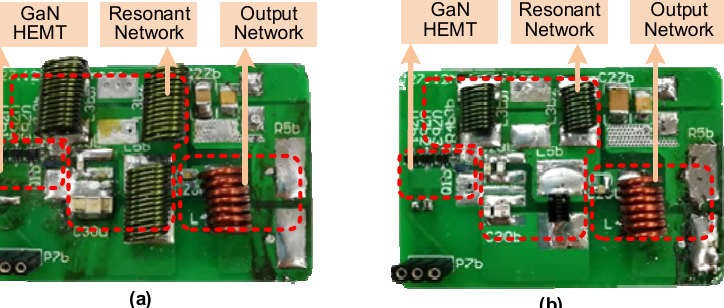
Figure 11. Block diagram of the prototype.